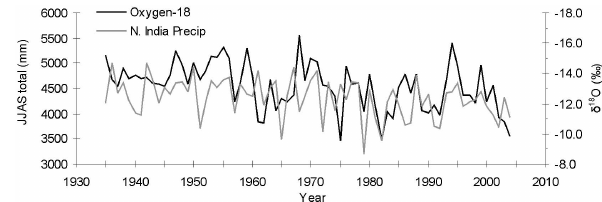
Fig. 6. Annual average δ 18 O variability plotted with North India monsoon rainfall (Sontakke et al., 2008). Note the reversed isotope